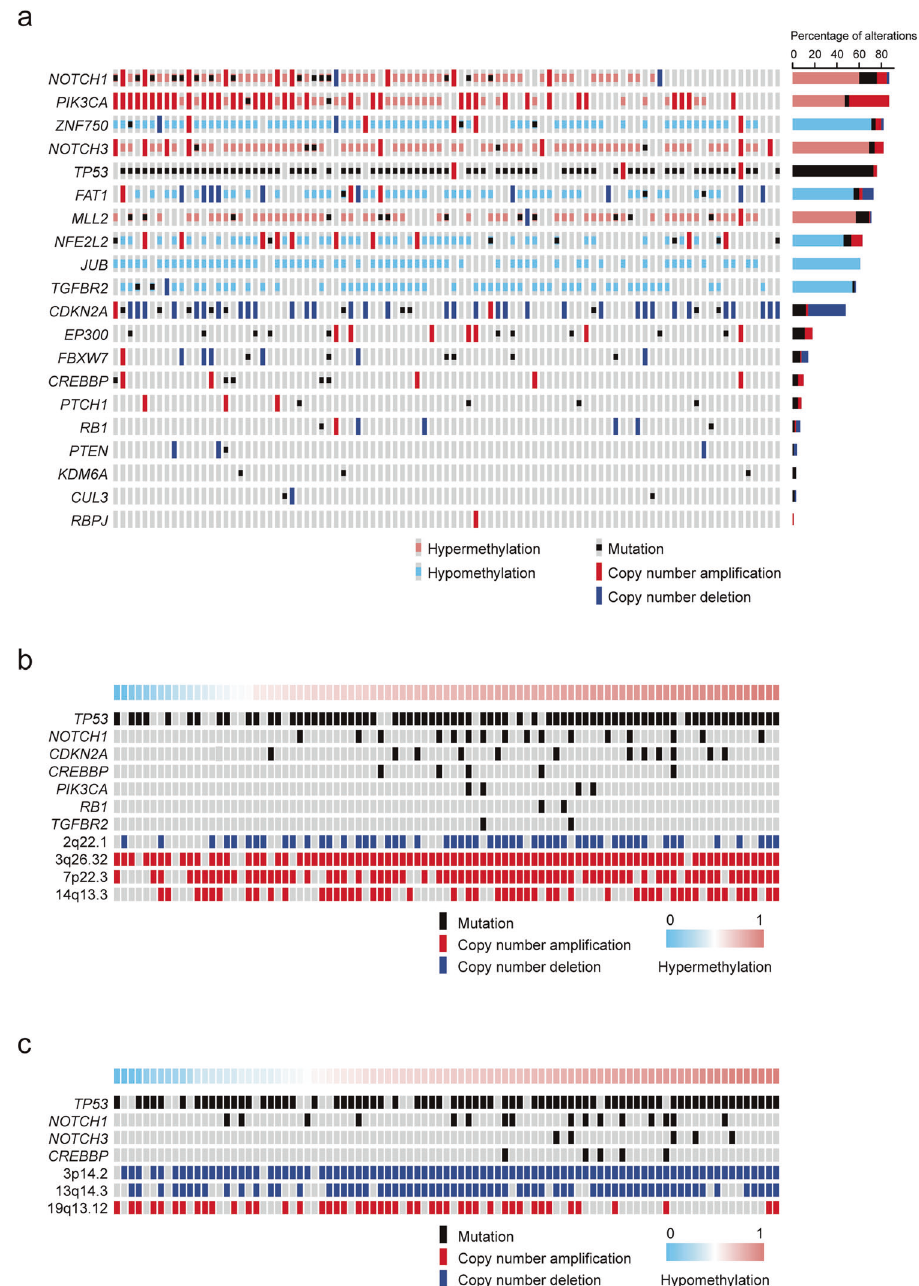
Fig. 3 Hyper- and hypo-methylation events across ESCC and integrated pro fi ling of ESCC driver genes. a Map overview of genetic and epigenetic alterations in 20 ESCC driver genes previously identi fi ed. ach column denotes an individual patient and each row represents the status of one gene including somatic mutations (black squares), copy number ampli fi cations (red bars), copy number deletions (blue bars), hyper- (pink bars) and hypo-methylated events (azure bars). Wild-type cases are in gray. Right, percentage of alterations for each gene in 91 ESCC patients while the X axis represents total percentage of alterations for each gene. b , c We tested recurrent genetic alterations in ESCC for their associations with frequency of hyper- ( b ) or hypo-methylated event ( c ). Signi fi cant associations (Wilcoxon P < 0.05) were shown in above and labeled by gene symbol for somatic mutations or cytoband for ampli fi cations and deletions. Each column denotes an individual patient and each row is one genetic alteration including somatic mutations (black bars), copy number ampli fi cations (red bars) and copy number deletions (blue bars). Wild-type cases are in gray. Top color bars represent the frequency of DNA methylation resides in the gene-body of NECAB2 . The expression levels of these of these genes were positively correlated with the methylation genes showed no signi fi cant difference between high and low levels in their gene bodies (all Spearman r > 0.30, P < 0.05, methylation groups of each marker except for NECAB2 (Supple- Supplementary Fig. S9e − l). mentary Fig. S8m − p). The expression levels of NECAB2 and Three of the four DMCs associated with the survival time in UBXN10 were signi fi cantly correlated with the methylation levels ESCC patients, cg23378365, cg06090867, cg03244277 locate at the of corresponding CpG sites ( NECAB2 , r = 0.42, P = 3.48e-5, promoters of CYFIP2 , UBXN10 and AREG , respectively; cg02370667